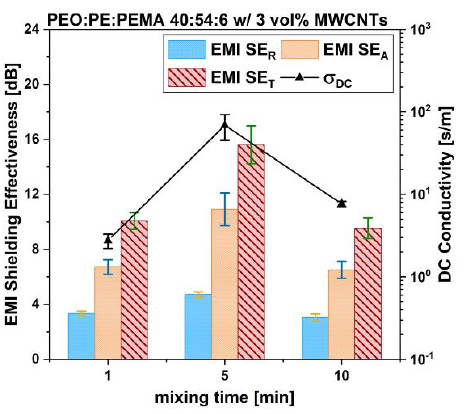
Figure 9. Low field detector (LFD) SEM images of PEO/PE/PEMA 40:54:6 with 3 vol% MWCNTs mixed for 1 min, 5 min, and 10 min.